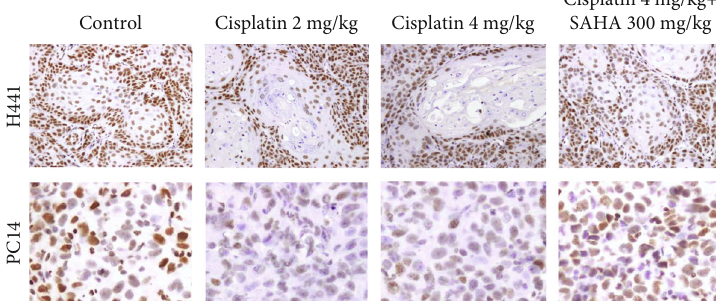
Figure 6: Immunohistochemical staining for AH3 in xenograft tumors. In H441 xenograft tumors, AH3 immunoreactivity was lower in Group A (2 mg/kg cisplatin) and Group B (4 mg/kg cisplatin) than the control group and was almost equal in Group C (4 mg/kg +300mg/kg SAHA) and the control group. Similar trends were observed in PC14 tumors; however, Group C exhibited a signi fi cantly higher increase in AH3 immunoactivity than Group B. Scale bar, 100 μ m.